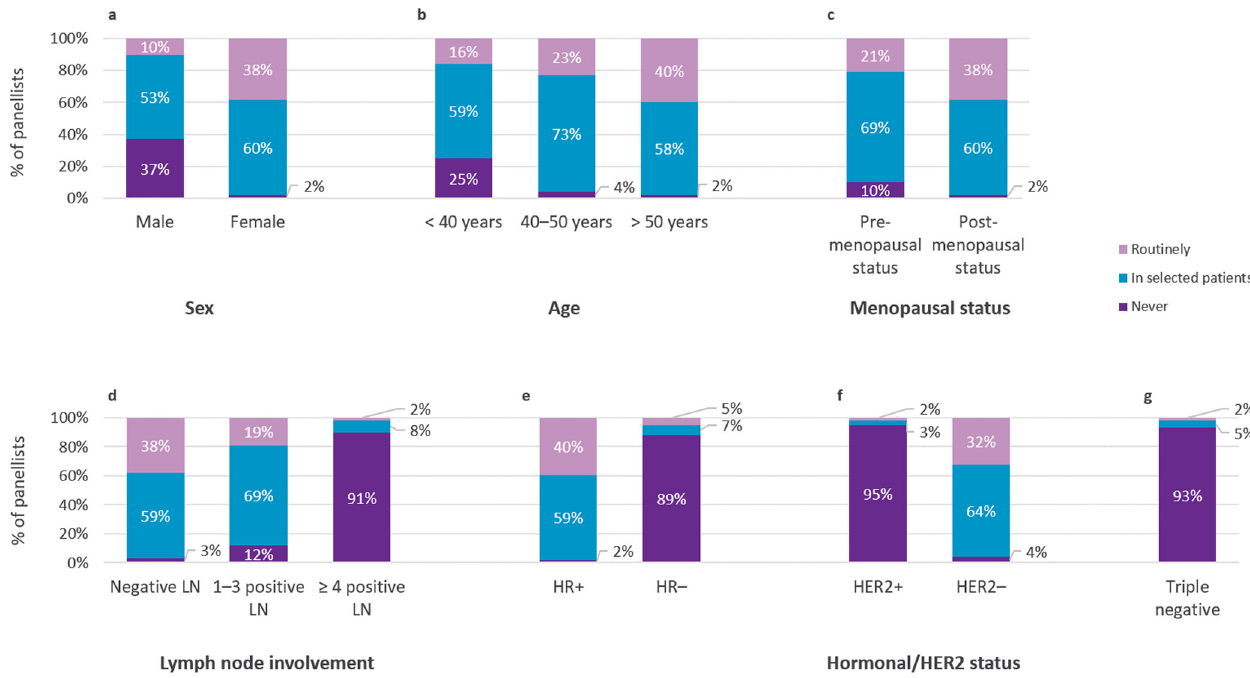
Fig. 3 Use of breast cancer multigene signatures to de fi ne prognosis and treatment decisions. Percentage of panellists stating the patient pro fi les with early breast cancer for which they use BCMS to de fi ne prognosis and treatment needs. LN lymph node, PR progesterone